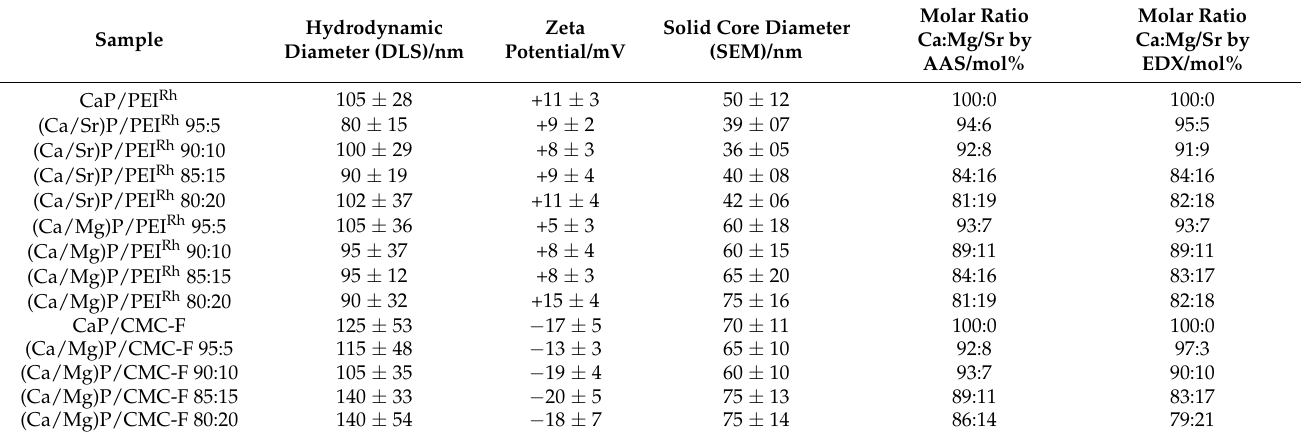
Table 1. Characterization of calcium phosphate-only nanoparticles as well as strontium- and magnesium-doped calcium phosphate nanoparticles, stabilized and labelled with either PEI Rh or CMC-F. The errors in the molar ratios of the elements are estimated to be about 5% (relative) for each element (for AAS and EDX results). In general, the results by AAS and EDX show a good agreement with a particle composition close to the ratio of the ions during